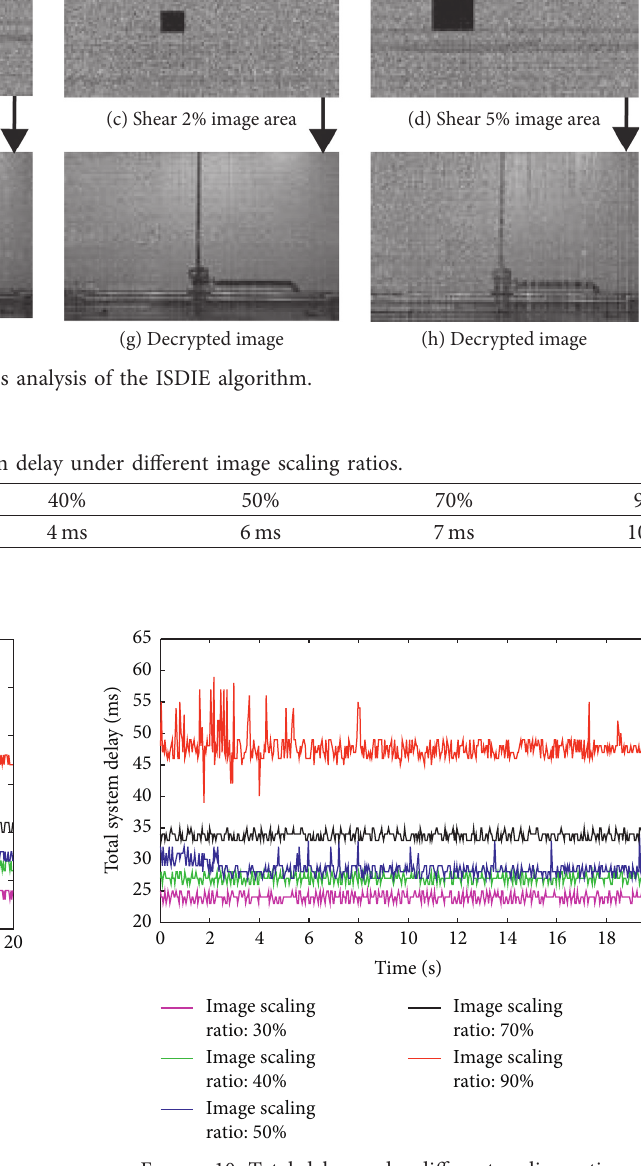
Figure 9: Encryption and decryption delay under different scaling ratios.